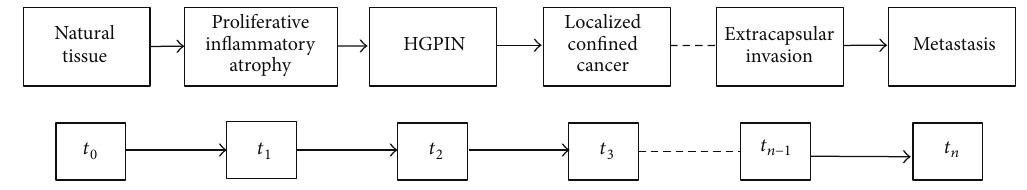
Figure 1: Multistate prostate carcinogenesis determined by the progression of different qualitative states identifiable in the development of cancer from normal tissue. The time parameter ( 𝑡 0 ,𝑡 1 ,...,𝑡 𝑛−1 ,𝑡 𝑛 ) depends on a large number of variables interconnected in many ways in a nonlinear manner. This makes it extremely difficult to predict the exact time interval between two successive states. Although carcinogenesis is a continuum, its differentiation into successive states is based on differences in histological and clinical data. Proliferative inflammatory atrophy (PIA) is a frequently observed lesion in prostate biopsies and some investigators have postulated its involvement in prostate carcinogenesis. PIA shares genetic alterations with high-grade prostatic intraepithelial neoplasia (HGPIN) and prostate cancer. HGPIN is currently regarded as the precursor lesion on the basis of pathological, epidemiological, and cytogenetic evidence. HGPIN lesions can be subdivided into at least four different architectural